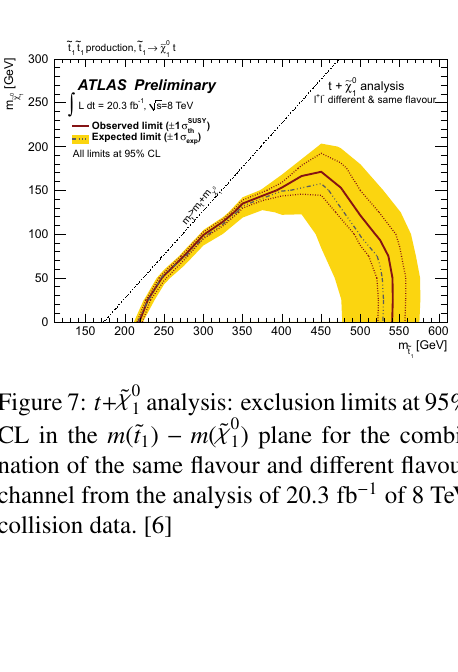
Figure 5: BDTG distribution in the t + ˜ χ 0 1 analysis after all selection requirements, except the cut on the BDTG itself, after the back- Figure 4: Distribution of m b-jet after all SR re- T2 ground fit and for the di ff erent flavour lepton itself. The quirements, except that on m b-jet T2 pair (top) and same flavour lepton pair (bottom) contributions from all SM backgrounds are channels, as obtained from the trainings which shown; the bands represent the total uncertainty. used the point ( m (˜ t ) , m (˜ χ 0 )) = (300,50) GeV and The component labelled “fake lepton" is esti- 1 ( m (˜ t ) , m (˜ χ 0 )) = (300,100) GeV, respectively. The mated from data and the component labelled 1 reference signal points used in the training of t ¯ t is shown re-normalised after the background each channel are also shown. [6] fit. [6]